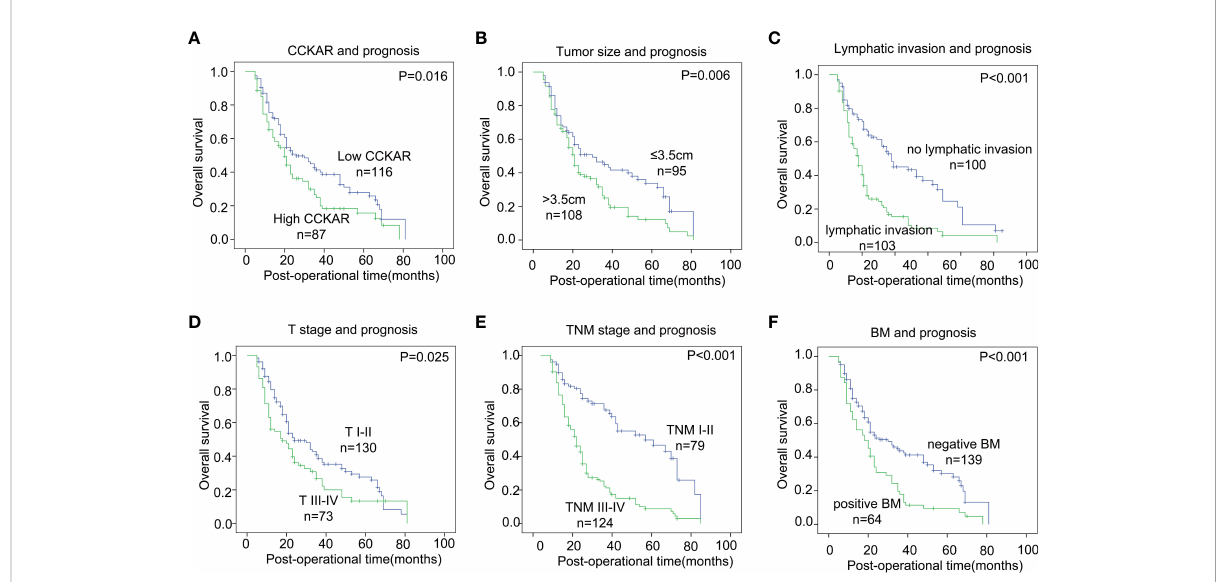
FIGURE 2 ThecorrelationbetweenNSCLCclinicopathologicalfactorsandoutcome.NSCLCpatientsweredividedintodifferentsubgroupsaccordingtoCCKAR